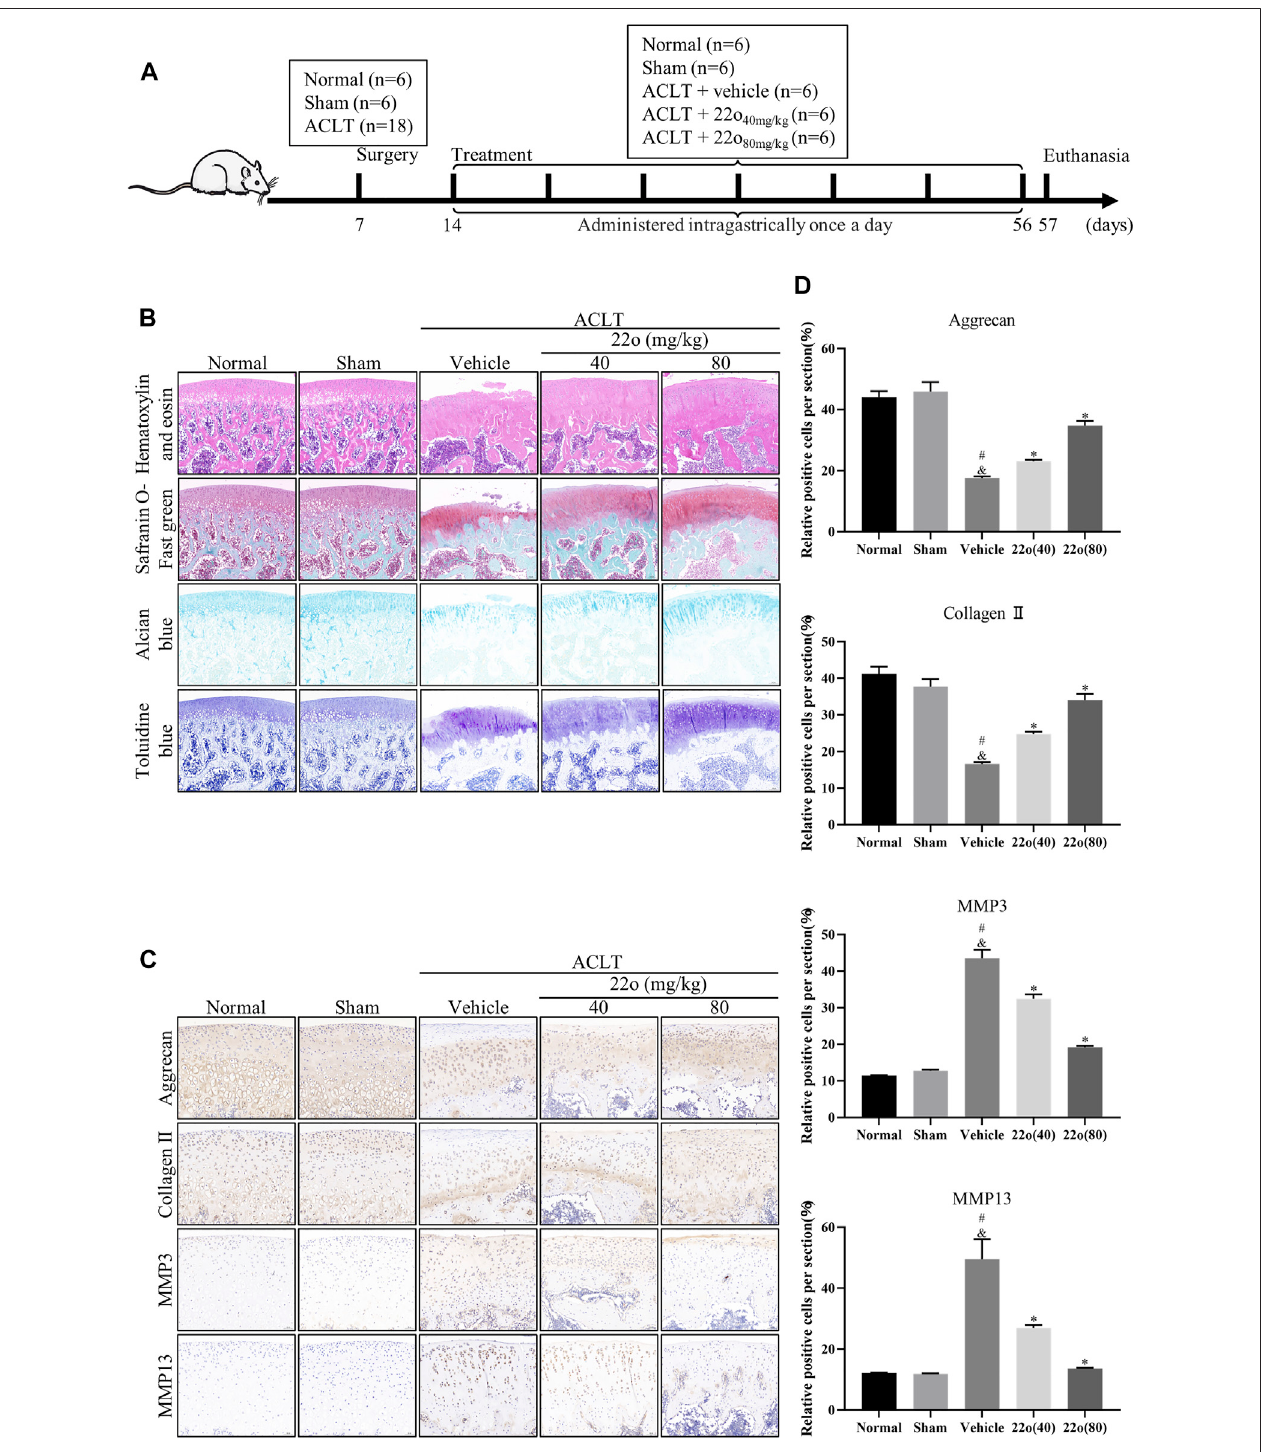
FIGURE 5 | Compound 22o alleviates the progression of OA. (A) Schematic diagram of the animal experiment design. (B) Representative images of HE, safranin O-fast green, alcian blue and toluidine blue staining of cartilage samples from fi ve groups 6 weeks after treatment (scale bars, 100 μ m). (C) Representative images of immunohistochemistry staining and (D) quantitative analysis of ACAN, COL2A1 MMP3 and MMP13 in the cartilage samples from fi ve groups 6 weeks after treatment (scale bars, 50 μ m, n = 6). # p < 0.05 vs. normal group; & p < 0.05 vs. sham group; * p < 0.05 vs. vehicle group.